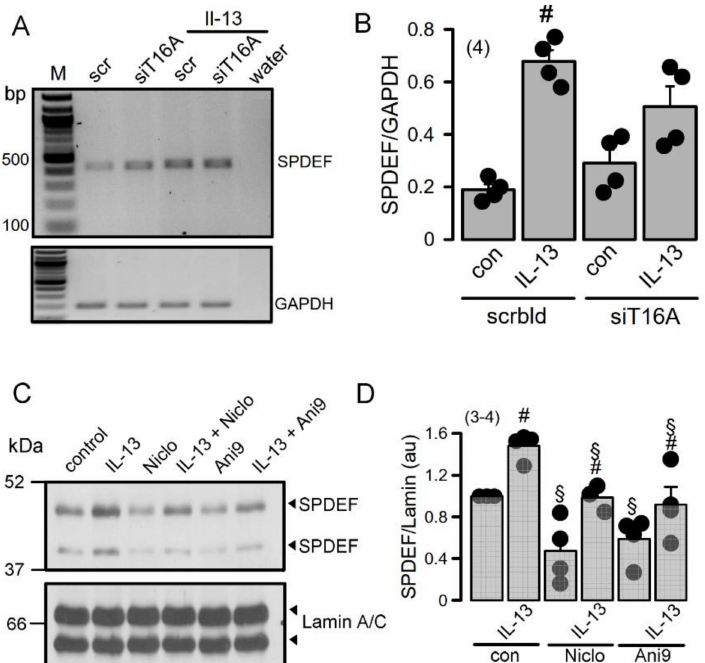
Figure 5. TMEM16A supports upregulation of the master switch for goblet cell metaplasia, SPDEF. ( A , B ) RT-PCR analysis suggests inhibition of SPDEF expression by siRNA-knockdown of TMEM16A. (number of experiments). ( C , D ) Western blots indicating inhibition of SPDEF expression by inhibitors of TMEM16A. (number of experiments). Mean ± SEM. # —significant difference when compared to scrambled, control, and L-13, respectively ( p < 0.05; unpaired t